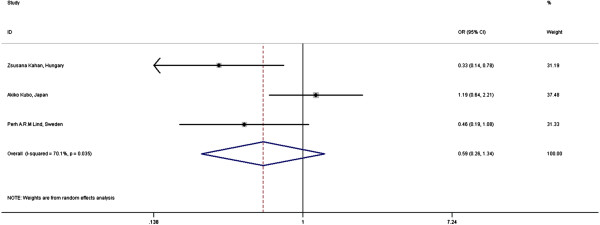
Meta-analysis: Effect of smoking on RP in 3D-CRT for BC.